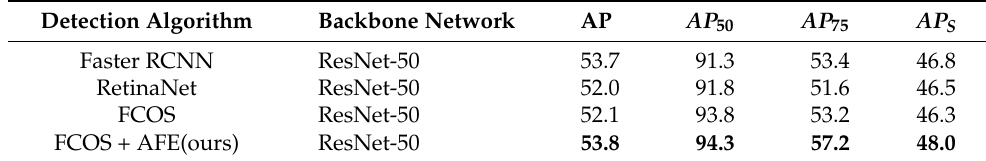
Table 6. Experimental results of the AFE Module on SSDD.